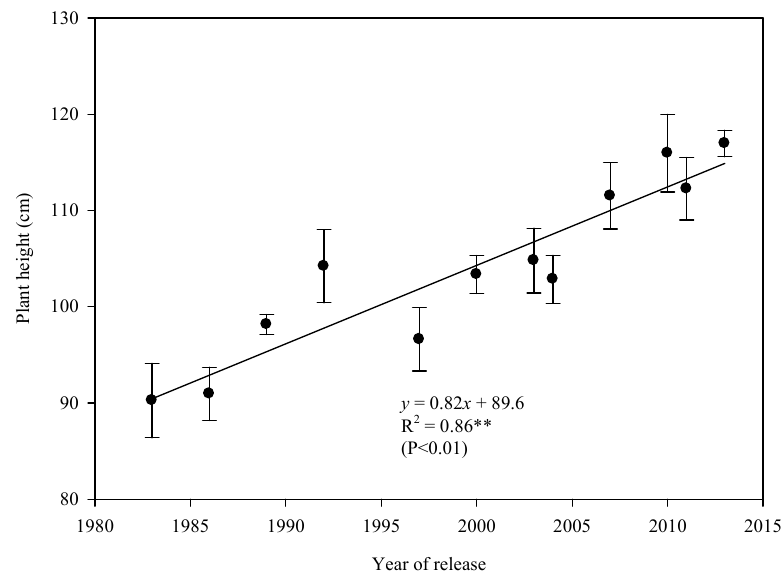
Figure 8. Relationship between year of release and plant height of rice cultivars. Data were fitted by linear regression ( y = a x + b). In the linear regression, x was reassigned as years after 1983; for example, x was valued as 1 in 1983 and so on. **, significant at the 0.01 probability level according to the LSD test. Vertical bars represent ± standard error of the mean ( n = 6).